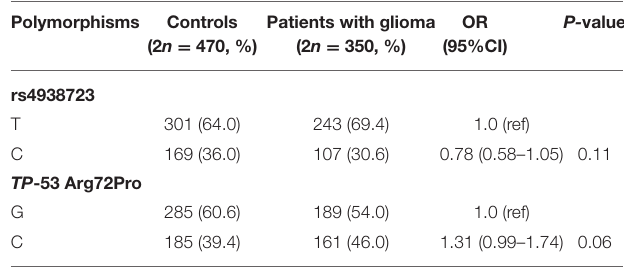
TABLE 1 | Characteristics of the study population. Variables